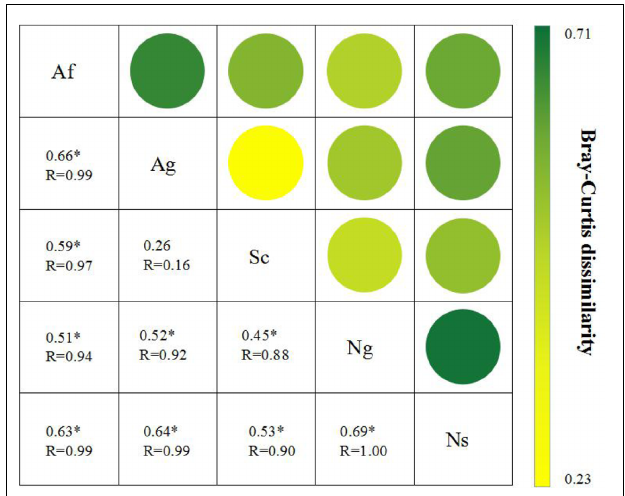
FIGURE 4 | The Bray-Curtis dissimilarity of fungal diversity among different land use types. ∗ Indicates that the fungal diversities were significantly different among land use types as detected by analysis of similarities (ANOSIM) using the Bray-Curtis distance. The R -values of the ANOSIM results, which were calculated based on 999 permutations, can be observed under the dissimilarity